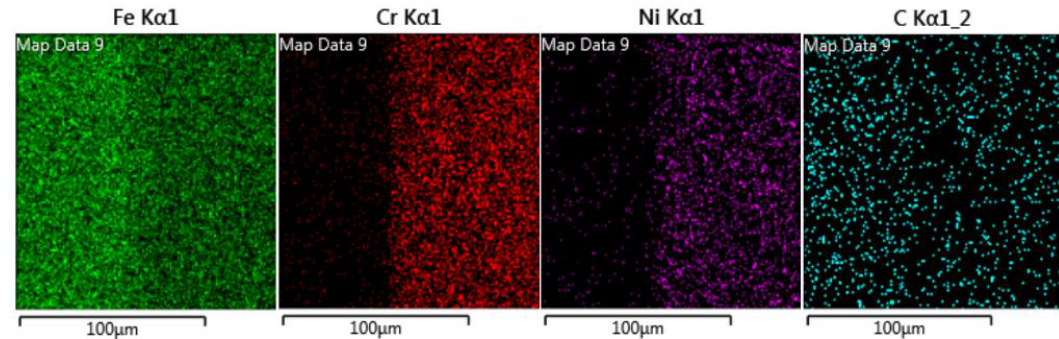
Figure 8. Line scanning analysis from substrate to deposition material without substrate preheating: ( a ) 1045 to 316 L; ( b ) P20 to 316 L; ( c ) 1045 to 316 L under preheating; ( d ) P20 to 316 L under preheating.